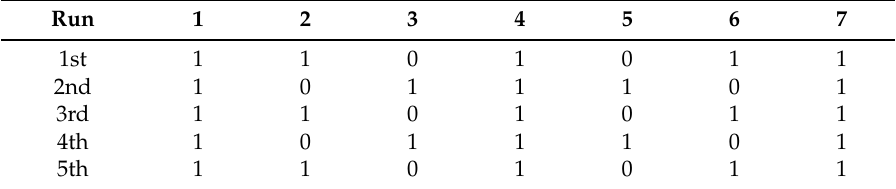
Table 5. Stochastic stop-skipping scheduling plan (‘0’ donates that the station is skipped; ”1”,